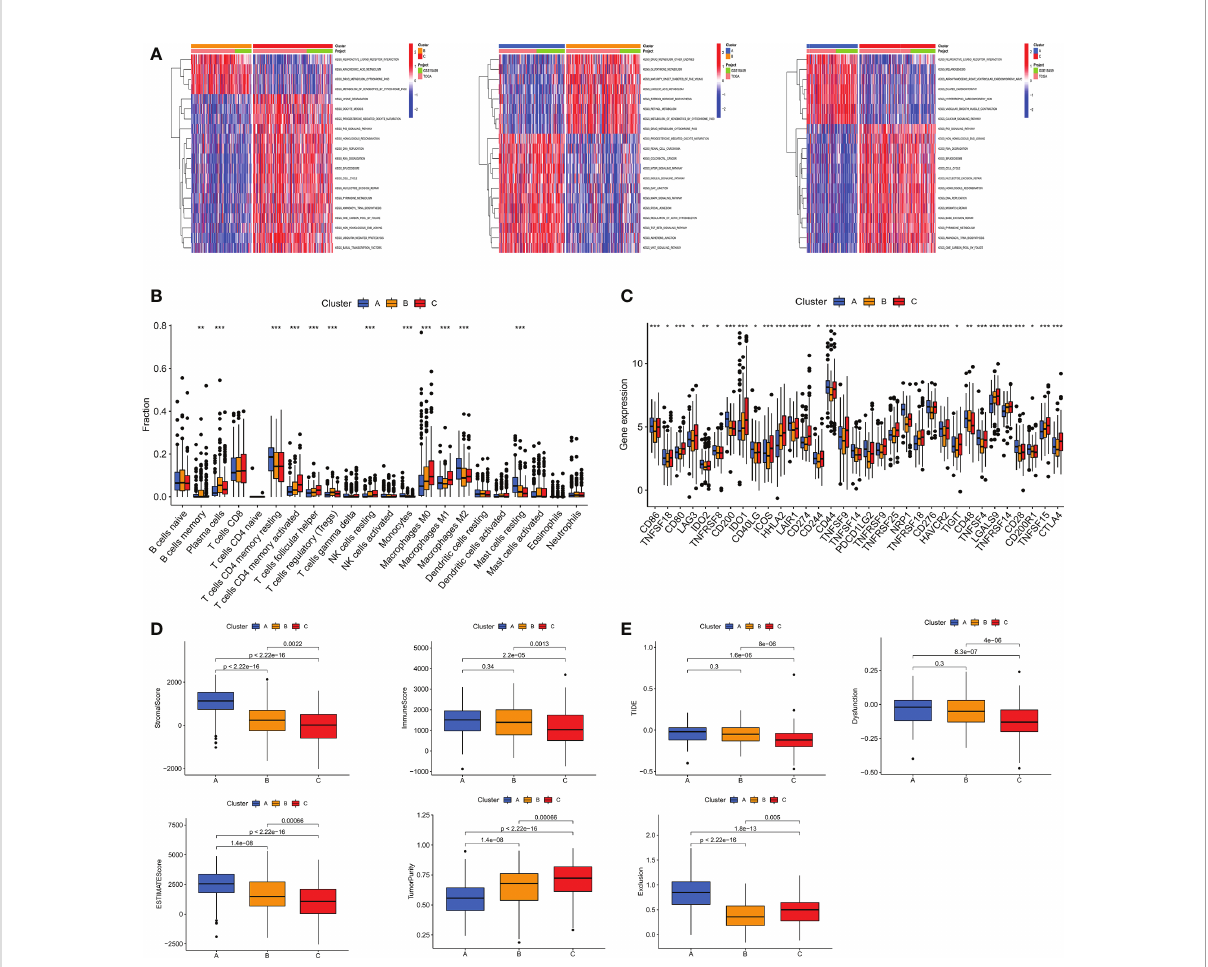
FIGURE 5 (A) GSVA pathway enrichment analysis between subtypes An and B, subtypes An and C, and subtypes B and C. (B) Differences in immune cell in fi ltration among different subtypes of GC were analyzed using the CIBERSORT algorithm. (C) Analysis of immune checkpoint expression among different subtypes. (D) The immune score, stromal score, ESITIMATE score and tumor purity among the three subtypes were calculated by ESITIMATE algorithm. (E) Immune dysfunction score, exclusion score and TIDE score among the three subtypes. TIDE, Tumor immune dysfunction and exclusion. *P < 0.05, **P < 0.01 and ***P <